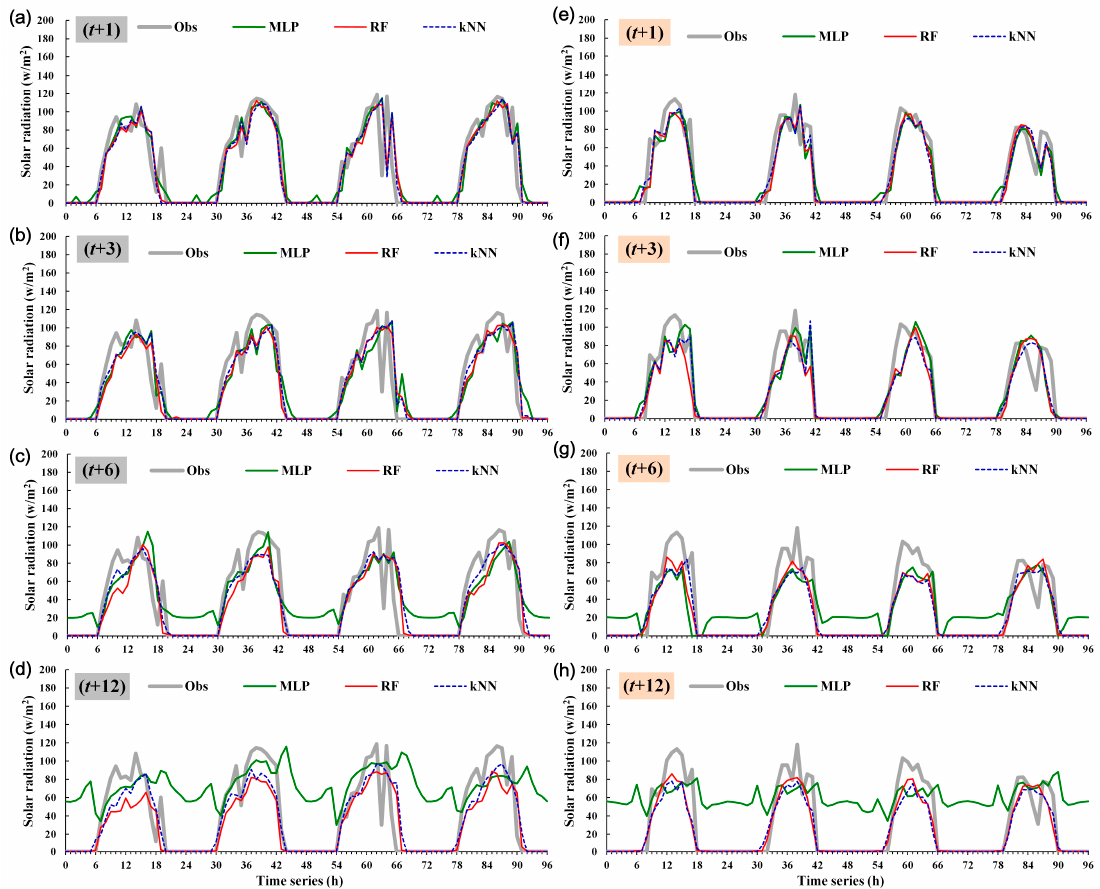
Figure 12. Observed values versus predicted changes in the diffuse horizontal irradiance within t + 1, t + 3, t + 6, and t + 12 for four consecutive days starting from: ( a – d ) the summer solstice, and ( e – h ) the winter solstice.